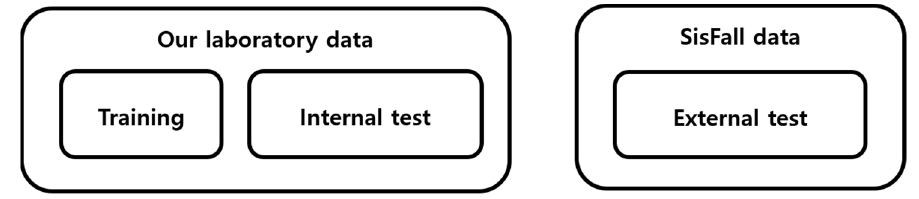
Figure 6. Internal and external tests